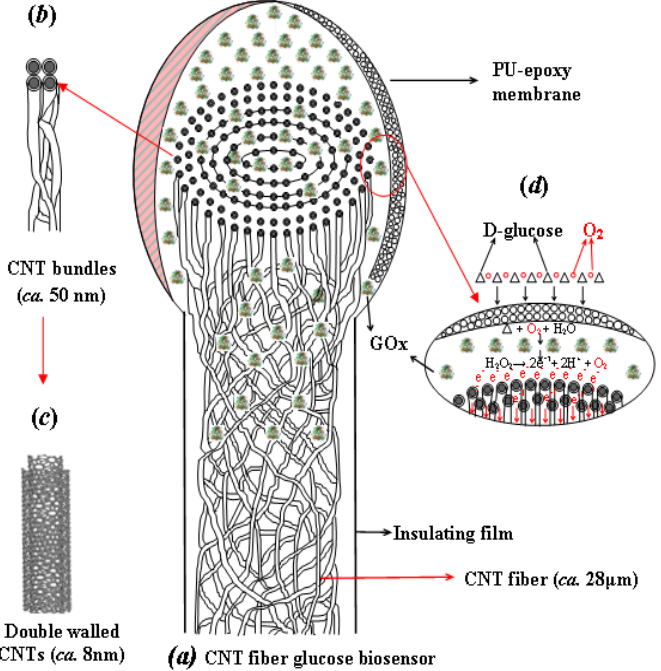
Figure 5. Schematic diagram showing ( a ) CNT fiber based glucose biosensor, ( b ) CNT bundles, ( c ) DWNT and ( d ) working principle of biosensor. The CNT fiber ( ca . 28 µm) is made of bundles ( ca . ~50 nm) of DWNTs ( ca . 8–10 nm) entangled to form concentrically compacted multiple layers of nano-yarns along the CNT fiber axis, as illustrated in (a). GOx (GOD) enzyme is immobilized at the brush-like end of the CNT fiber and the enzyme layer is encapsulated by the epoxy-polyurethane (EPU) semi-permeable membrane